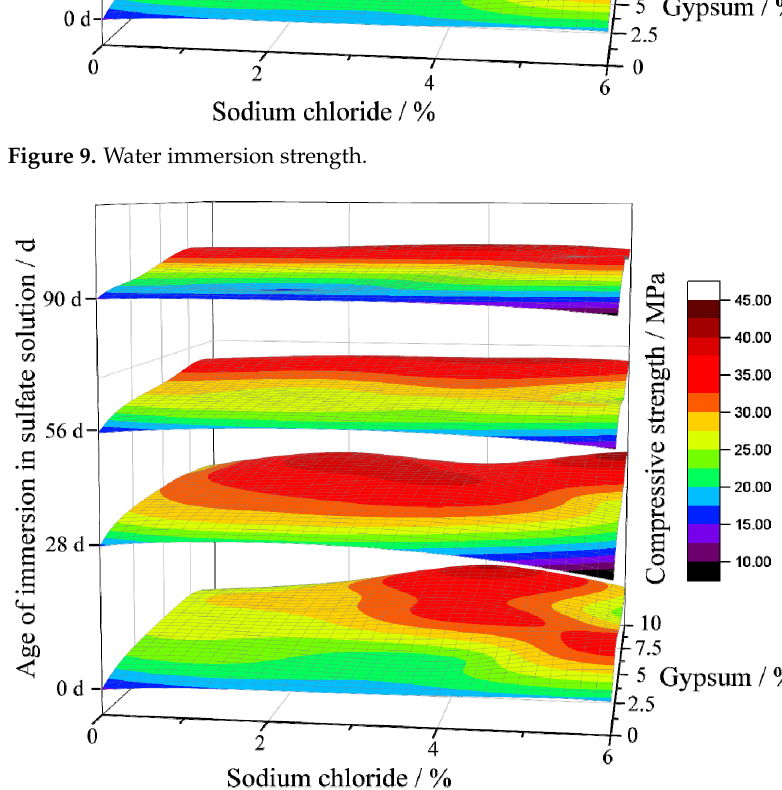
Figure 10. Sulfate immersion strength.